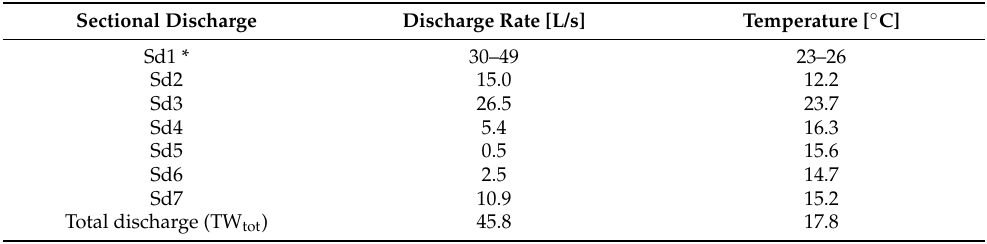
Table 2. Mean values of sectional discharges from May 2020 to May 2021 (* estimated values). Bottom row shows total discharges and average temperature measured during